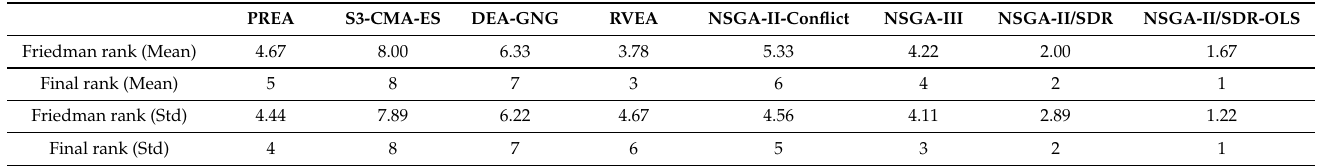
Table 18. The ranking of the Friedman